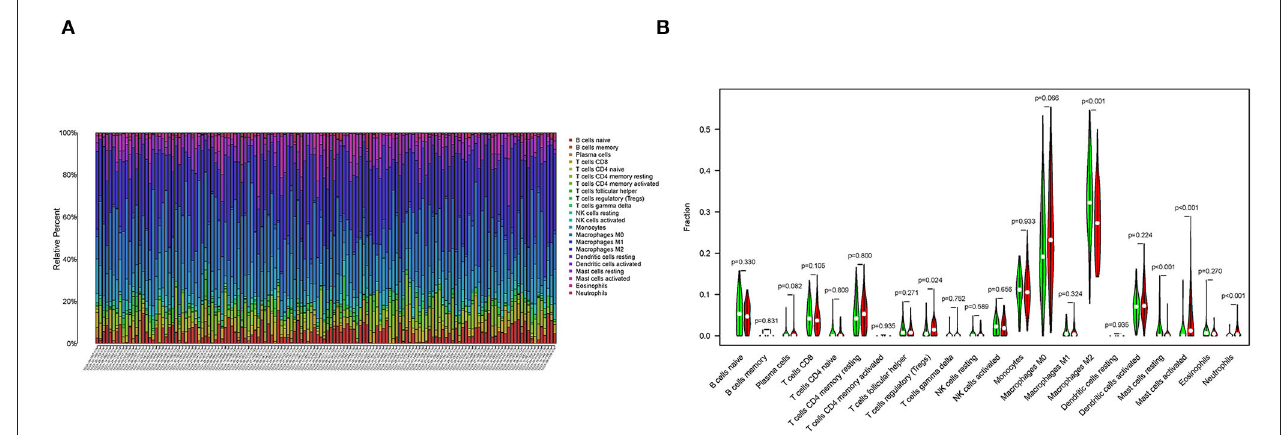
FIGURE 10 | TICs profile of GBM and correlation analysis. (A) The bar plot shows the proportion of 22 types of immune cells in GBM samples, and column names are sample IDs. (B) The Violin plot shows the differentiation ratio of 22 types of immune cells in GBM samples with low or high expression relative to the median SAA1 expression level. Wilcoxon rank-sum test was used to determine the